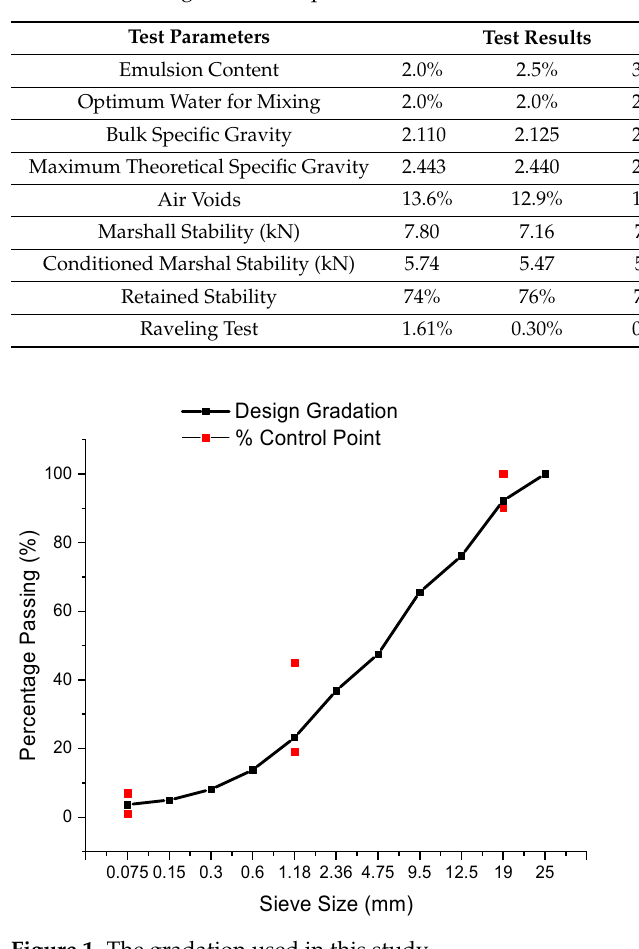
Table 1. Mix design for CIR asphalt mixture.